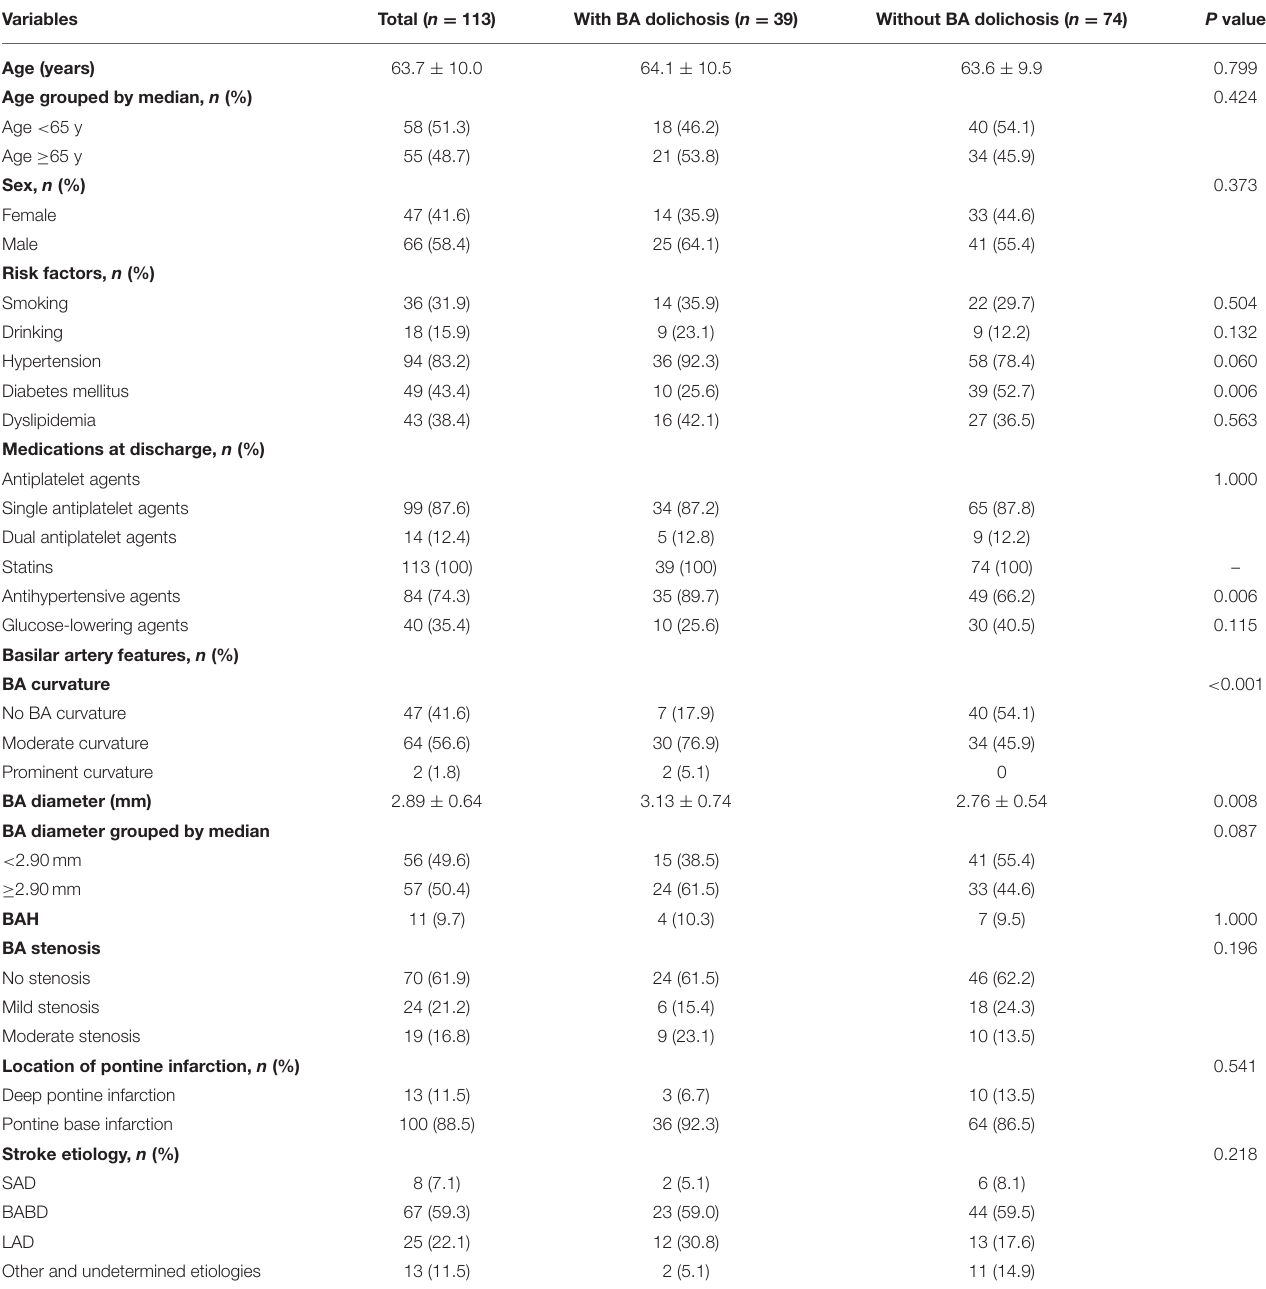
TABLE 1 | Clinical